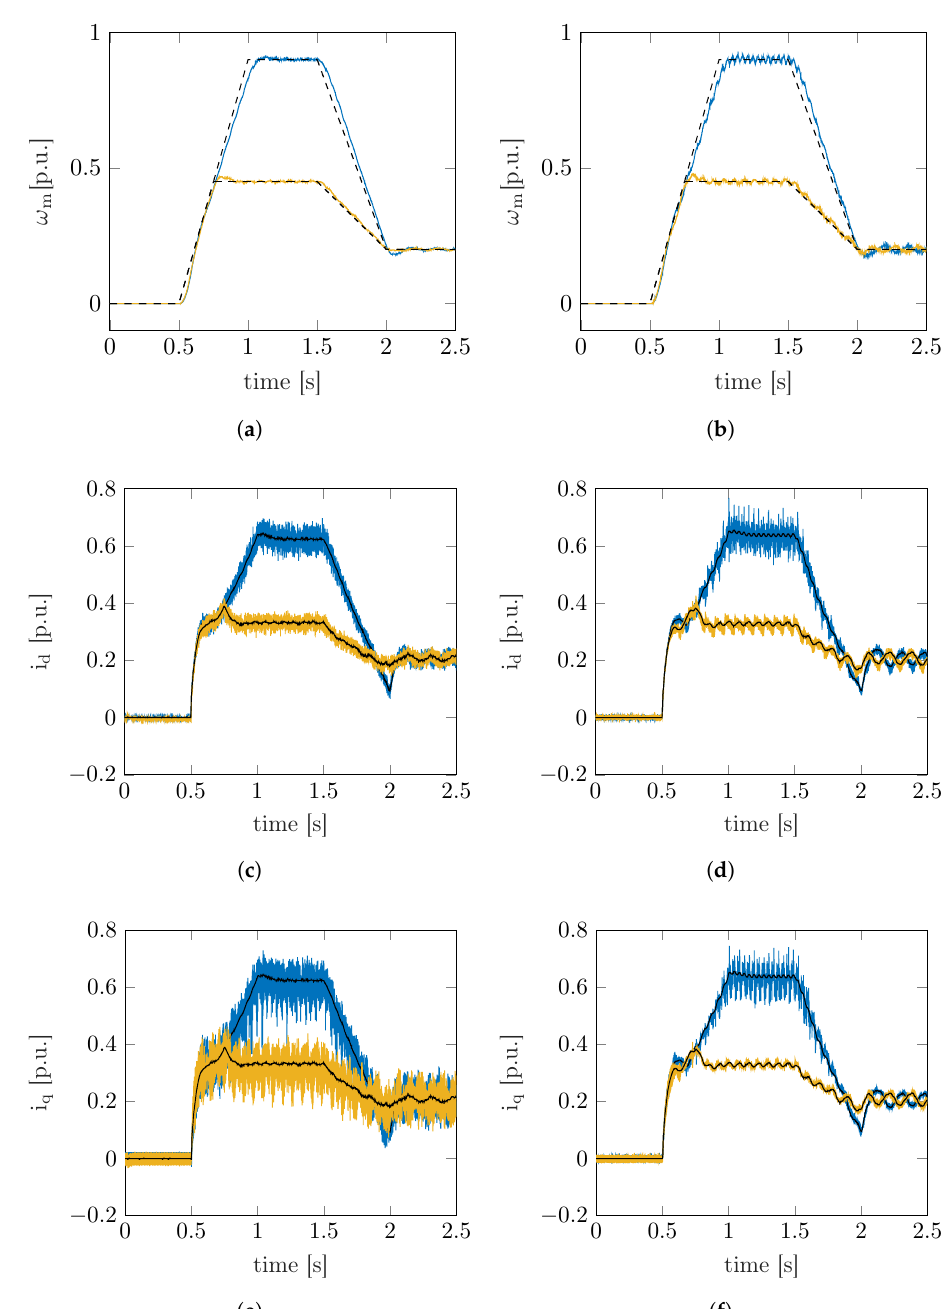
Figure 5. Pump load emulation results of the motor under test SynRM 1 . Figures ( a , c , e ) report the results of model-free FS-PCC [25]; Figures ( b , d , f ) report the results of the proposed model-free